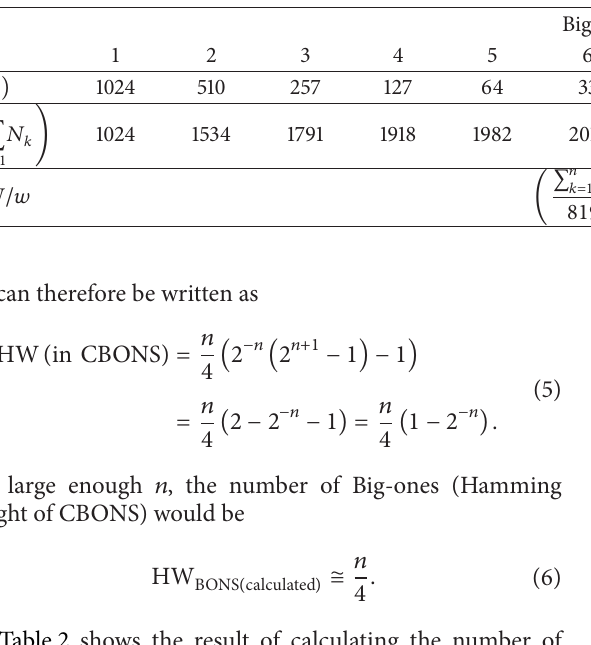
Table 2: The Hamming weight of Big-ones in CBONS for an 8-Kbit binary